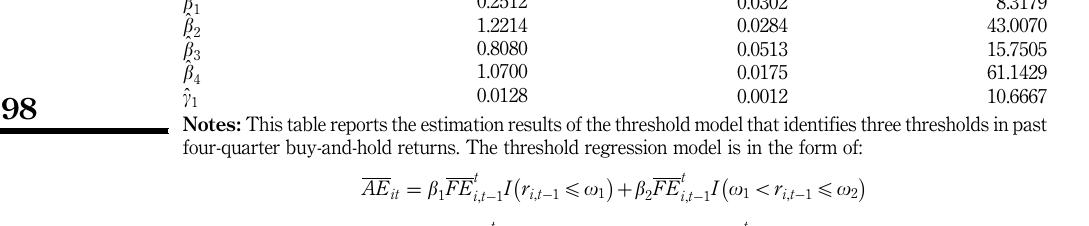
Table VII. Estimation results of the threshold model with three